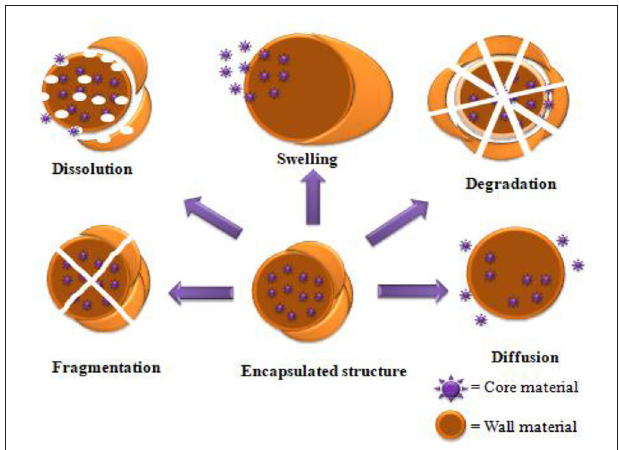
FIGURE 2 | Mechanisms for the release of active ingredient from the edible films/coatings into the desired food product (Adapted from Boostani and Jafari,